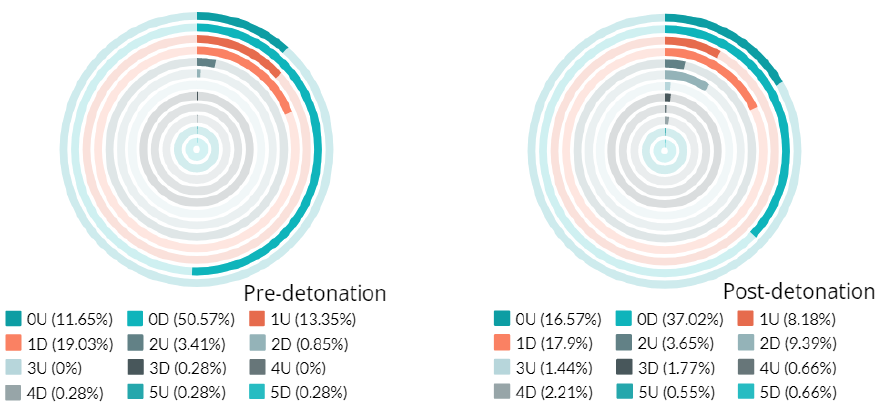
Figure 8. Percentage of whistles encoded by morphology-based categorization. The outer arcs correspond to the less complex whistles and the inner arcs correspond to the whistles with increasing inflection points.